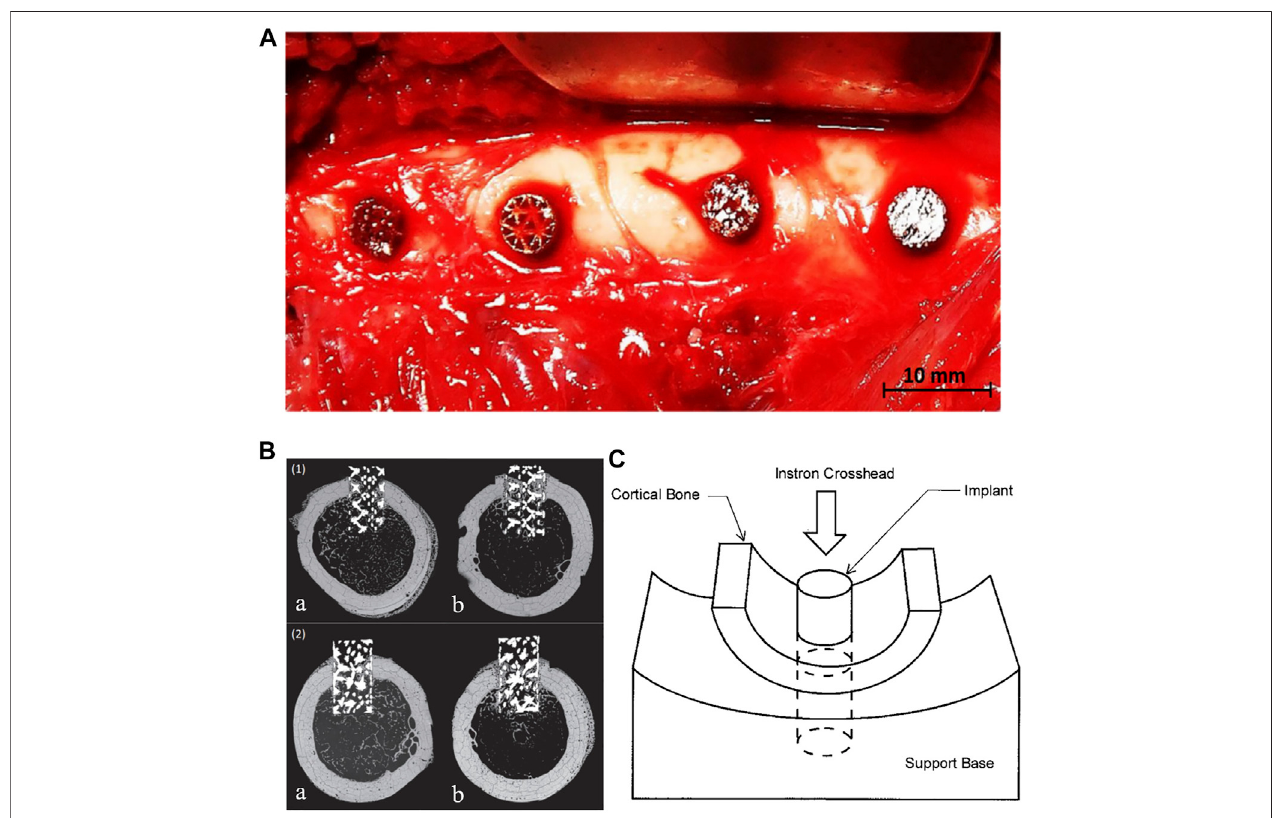
FIGURE6|(A) Intraoperativephotographofporousimplantsinthelateralfemoralcortex. (B) Backscatteredscanningelectronmicrographofatransverse(1)Octet truss and (2) Tetrahedron transcortical implant section at (a) 4 weeks and (b) 8 weeks. Bone ingrowth can be seen throughout the length of the implant at 8 weeks after surgery (Arabnejad et al., 2016). (C) Diagram of push-out test. (Bobyn et al., 1999).